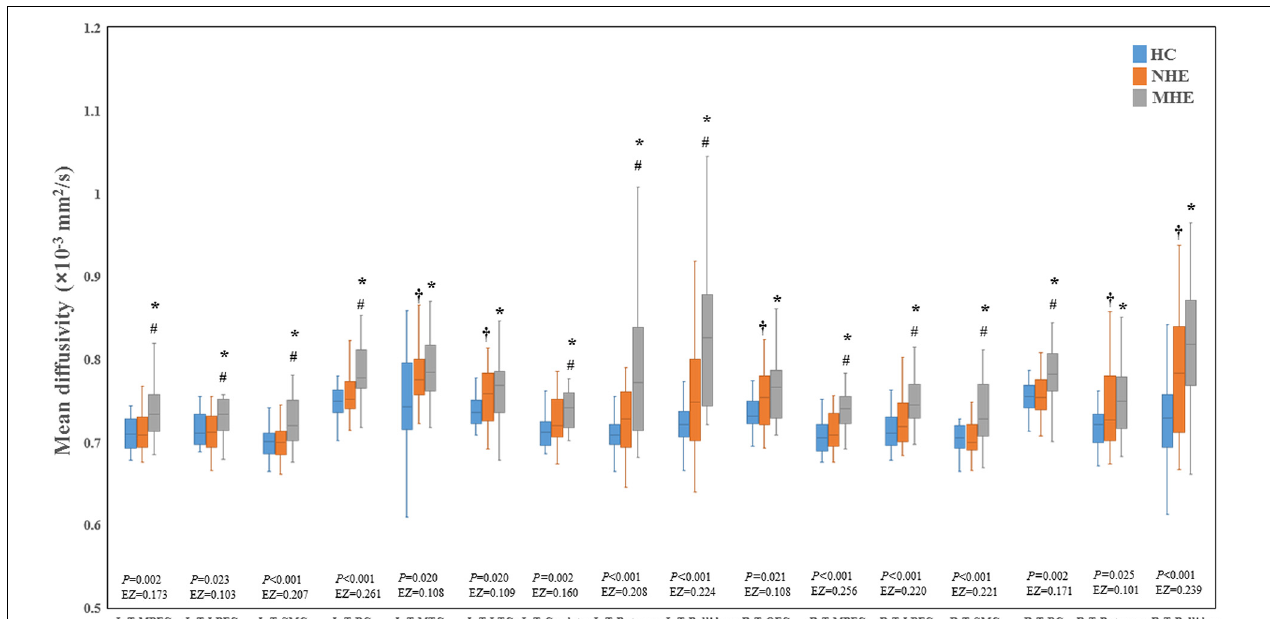
FIGURE 4 | Between-group differences in mean diffusivity. The false discovery rate (FDR)-corrected P values and the effect size (EZ) are shown. The symbols *, † , and # indicate significant differences in MHE vs. HC, NHE vs. HC, and MHE vs. NHE, respectively. MHE, minimal hepatic encephalopathy; NHE, patients without MHE; HC, healthy control; LPFC, lateral prefrontal cortex; LTC, lateral temporal cortex; MPFC, medial prefrontal cortex; MTC, medial temporal cortex; OFC, orbitofrontal cortex; PC, parietal cortex; SMC, sensorimotor cortex; T, thalamus; L, left; R, right.